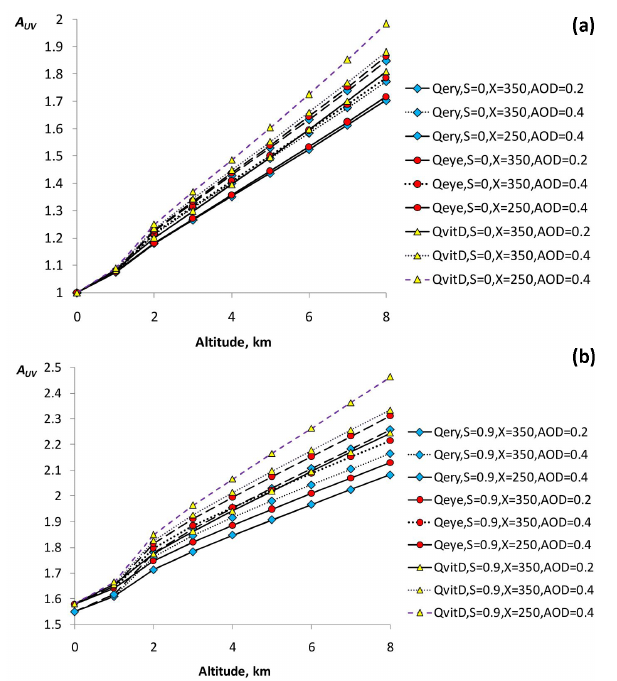
Figure 9. Total UV amplification as a function of the altitude for different types of BAUVR in a variety of atmospheric conditions with S = 0 (a) and S = 0 . 9 (b) . The model parameters at H = 0km: X = 250–350DU, AOD 340 = 0 . 2–0.4. The Alpine type of AOD al- titude dependence according to the Eq. (15) was taken into account. Solar elevation h = 50 ◦ .